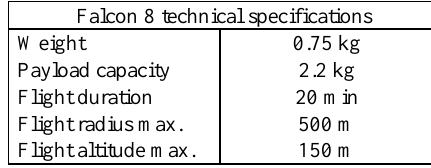
Table 1 – Technical specifications of UAS Falcon 8.